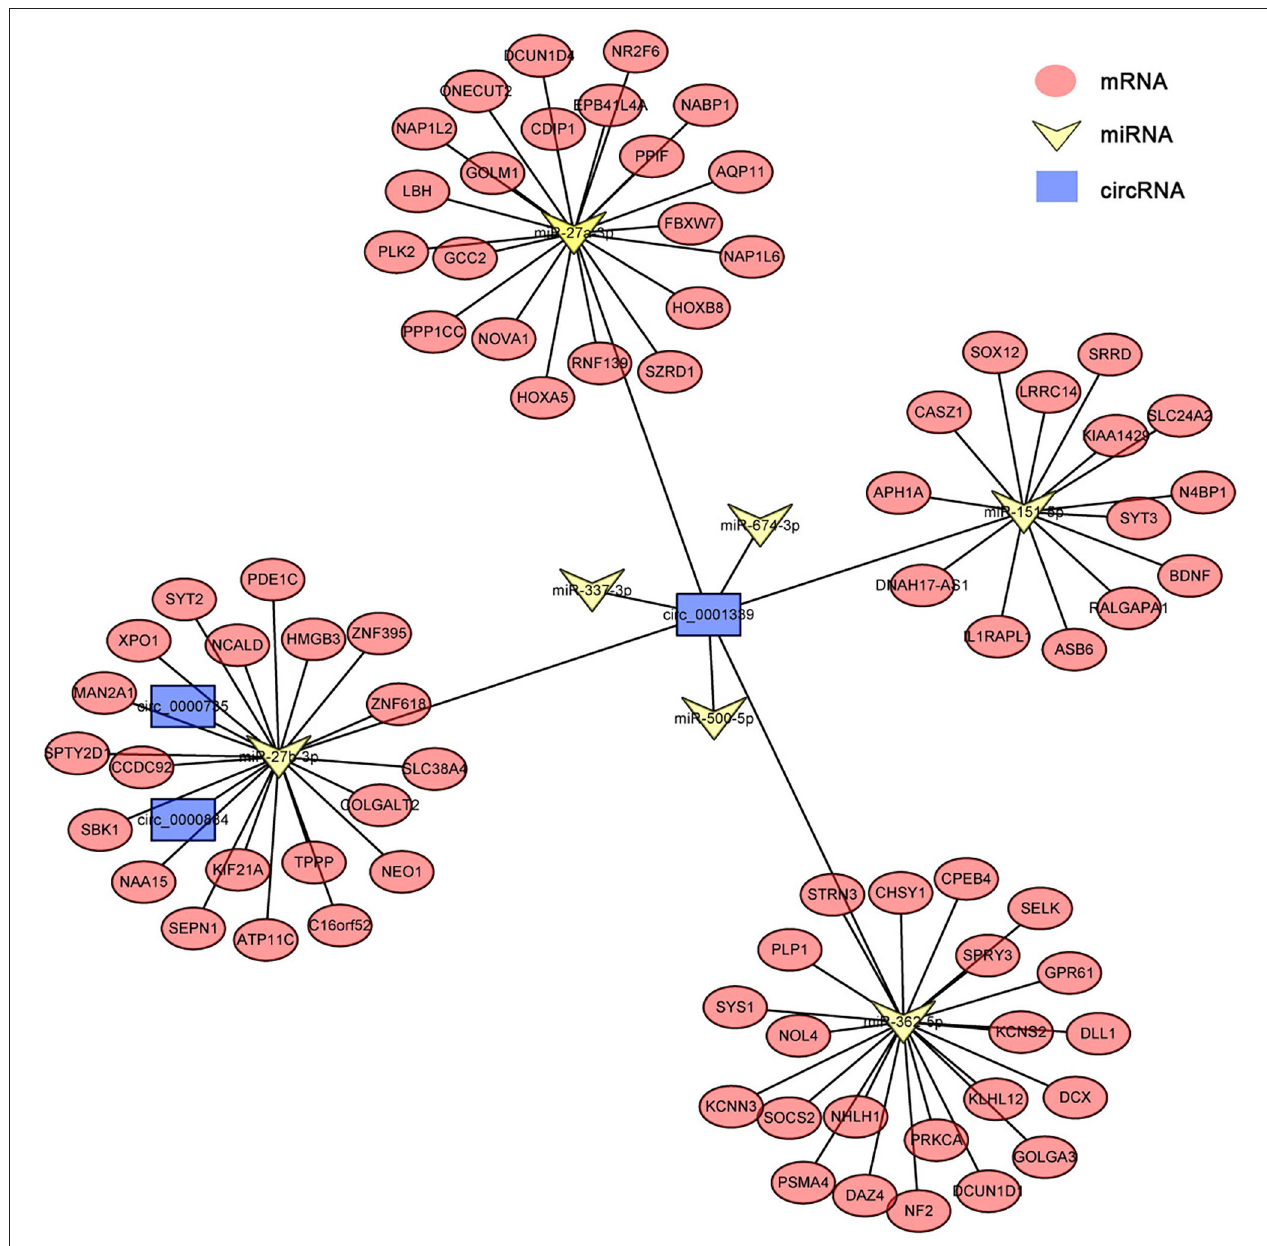
FIGURE 4 | circRNA–miRNA–mRNA network diagram of hepatic stellate cells. Blue, yellow, and red nodes correspond to circRNAs, miRNAs and mRNAs, respectively. The black lines correspond to the interactions between RNAs.